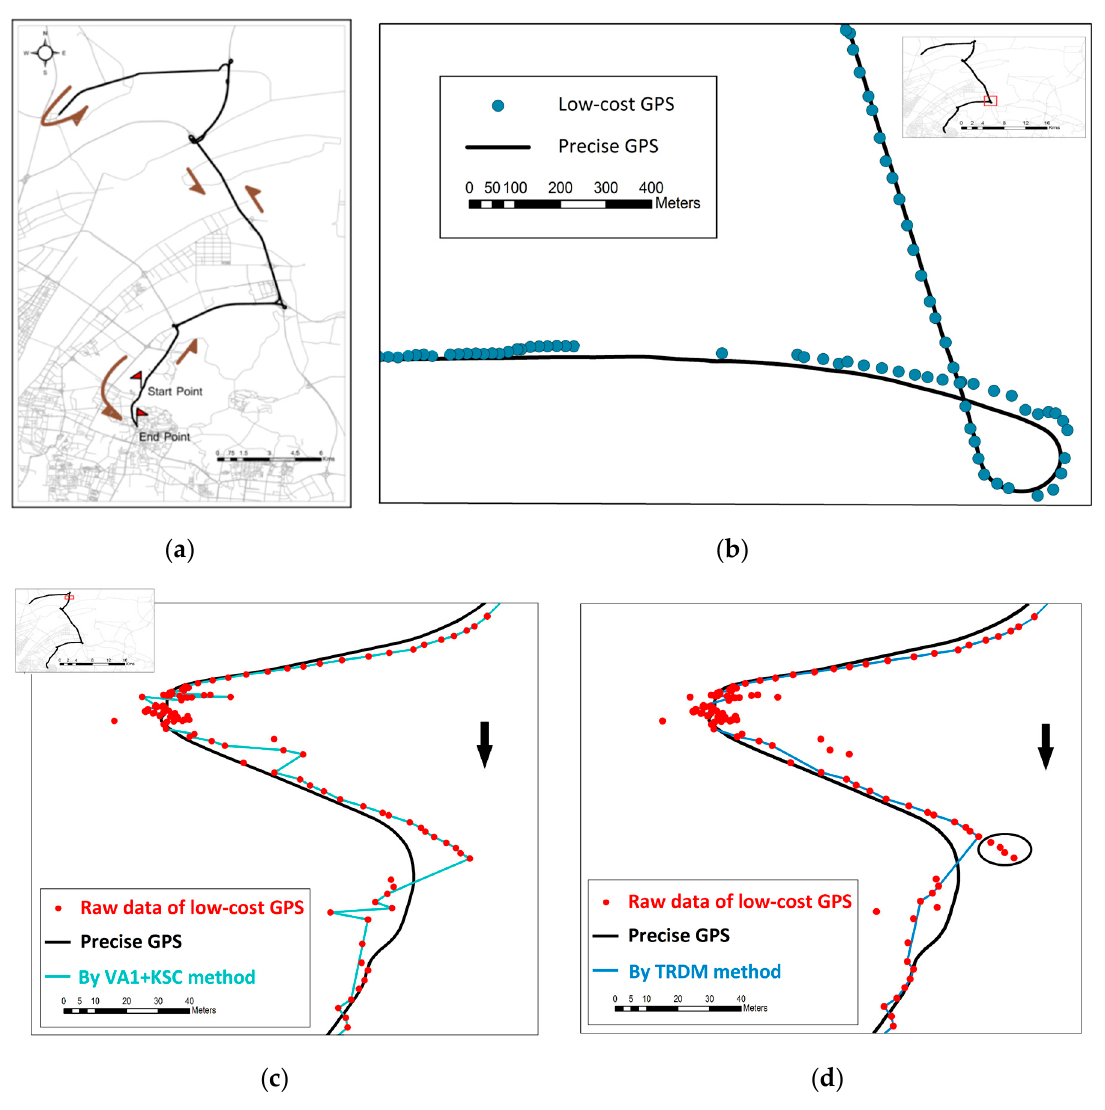
Figure 3. A vehicle route and its outlier detection outcomes. ( a ) Driving route; ( b ) A sample section of the route where the records of low-cost GPS fit well with the precise GPS; ( c ) Cleaned problematic trajectory segment using the VA1 + KSC method; ( d ) Cleaned problematic trajectory segment using the TRDM method.